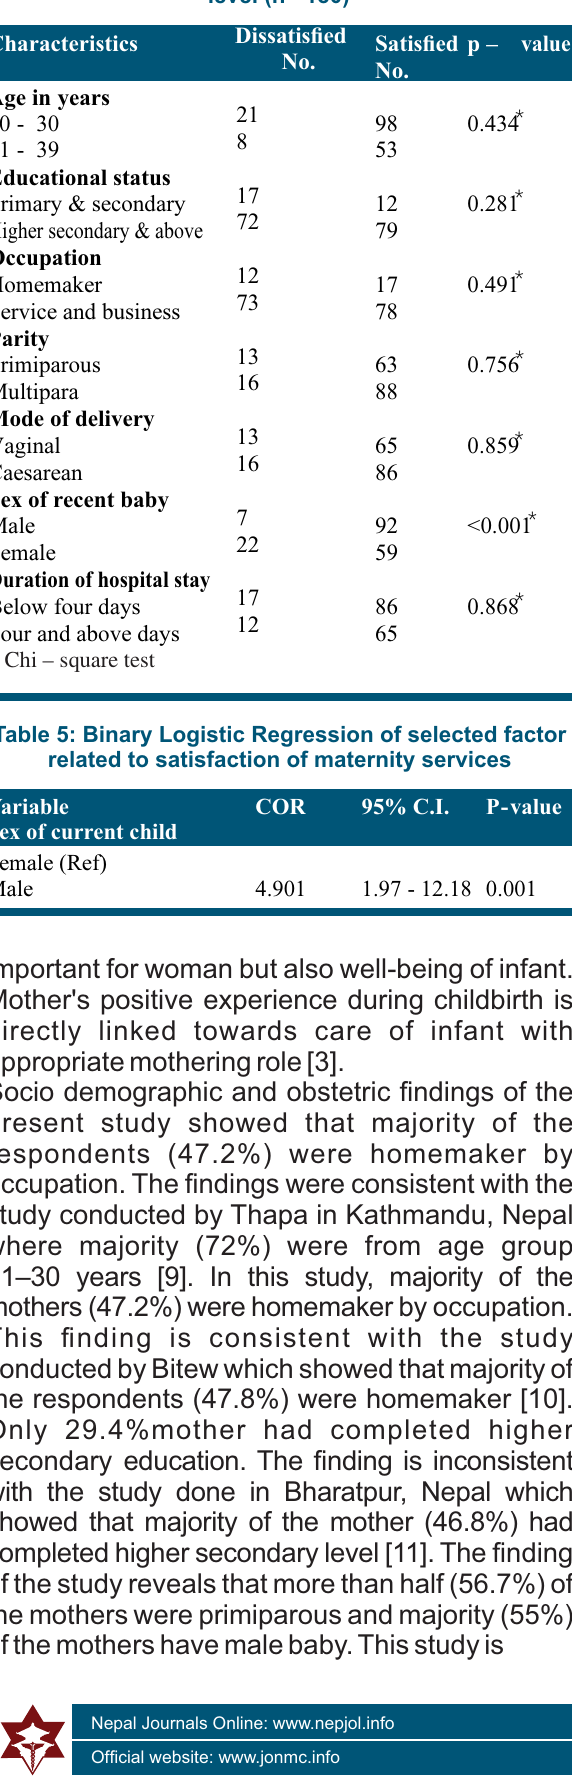
Table 4: Association between socio demographic and obstetric characteristics with